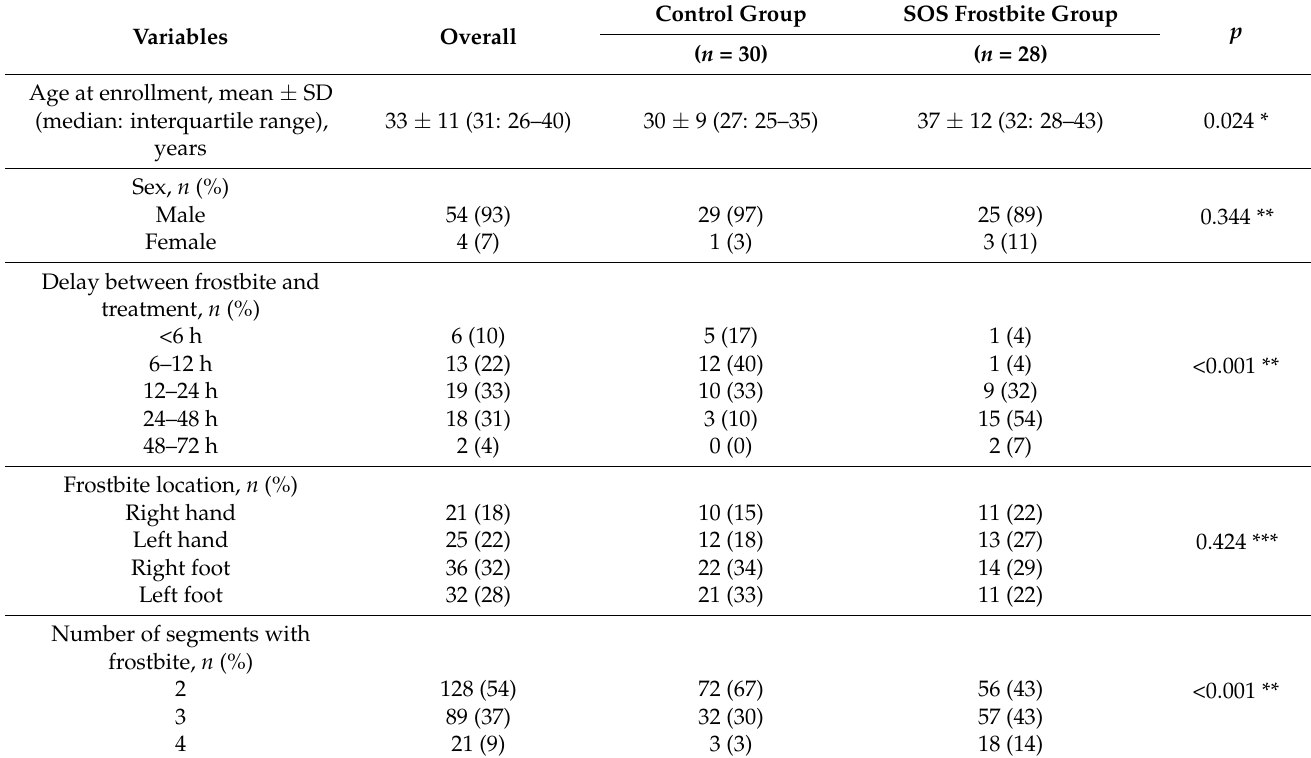
Table 1. Description of patients included in the study ( n = study), the number of preserved digits, and the number of amputated